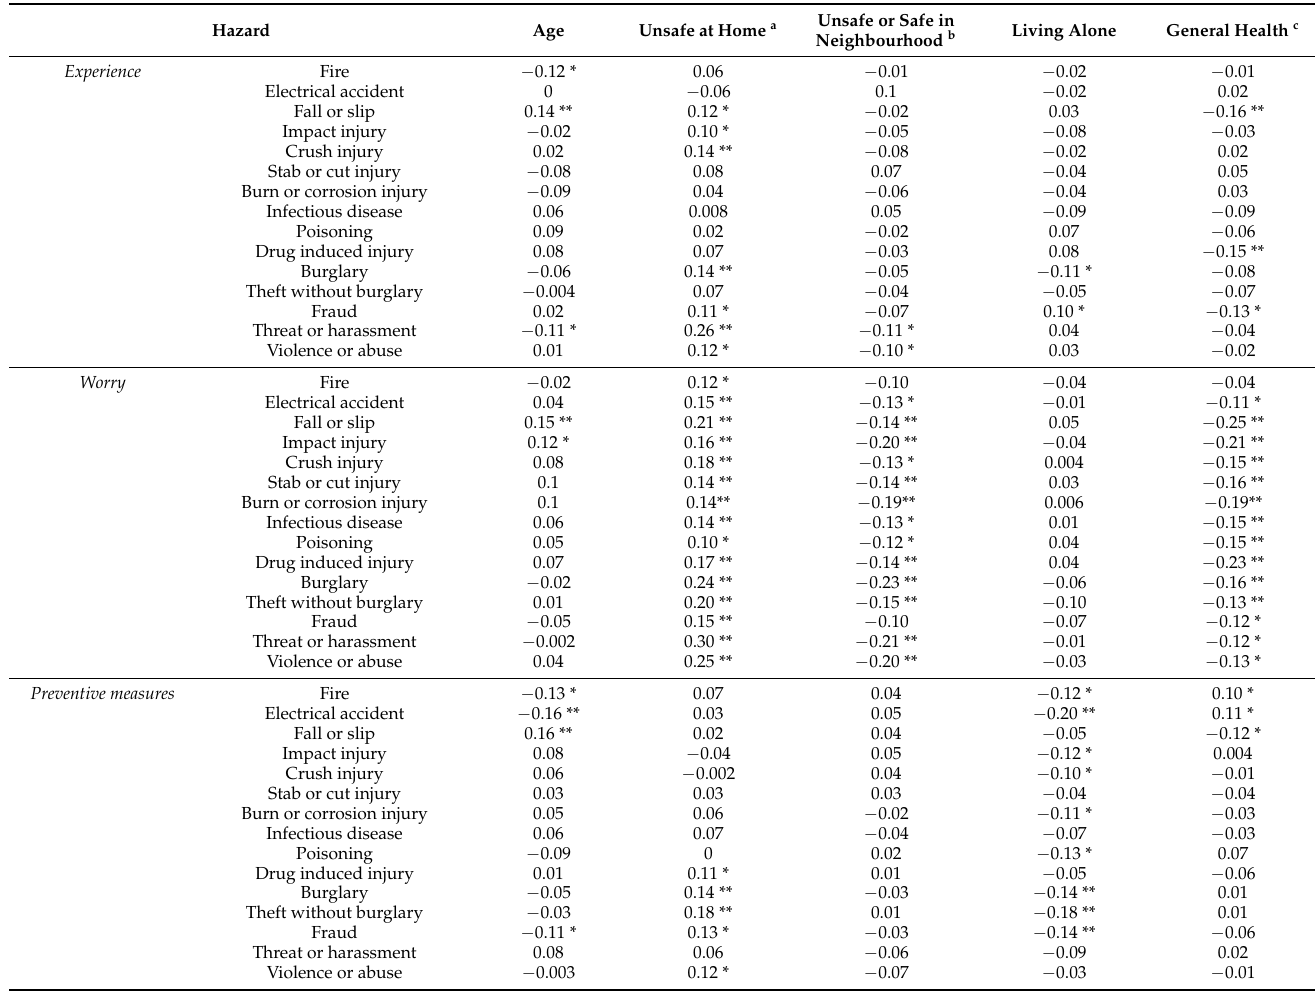
Table 4. Associations between demographic and background variables with experience, worry, and preventive measures for 15